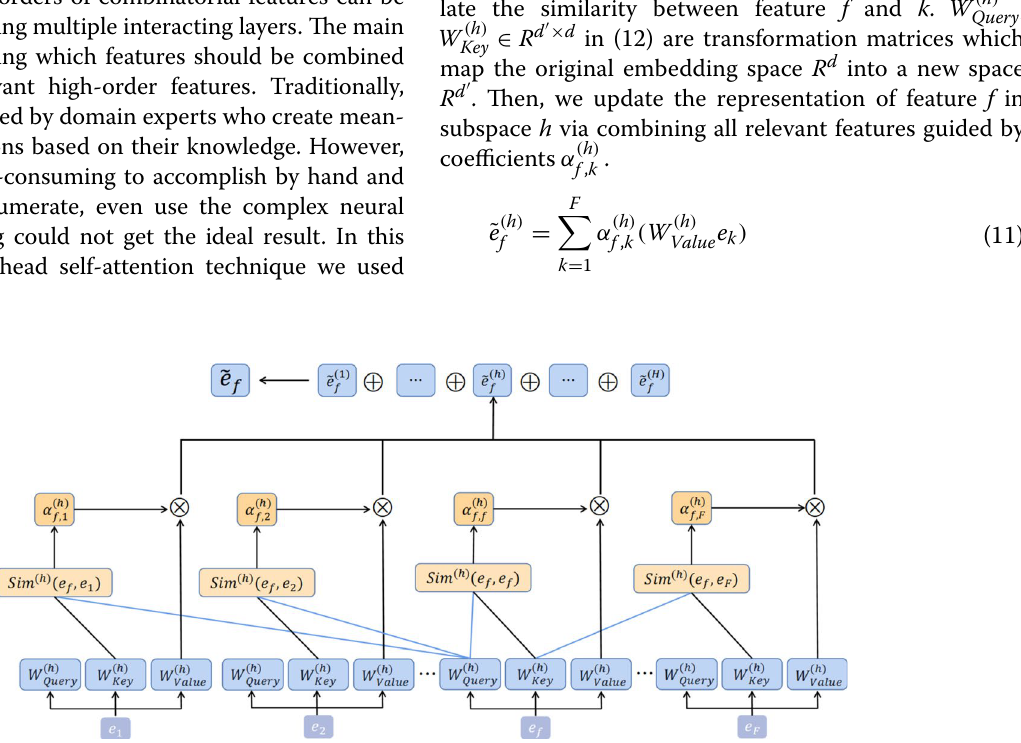
Fig. 5 The architecture of interacting layer. Combinatorial features are conditioned on attention weights, i.e., α ( h ) f ,